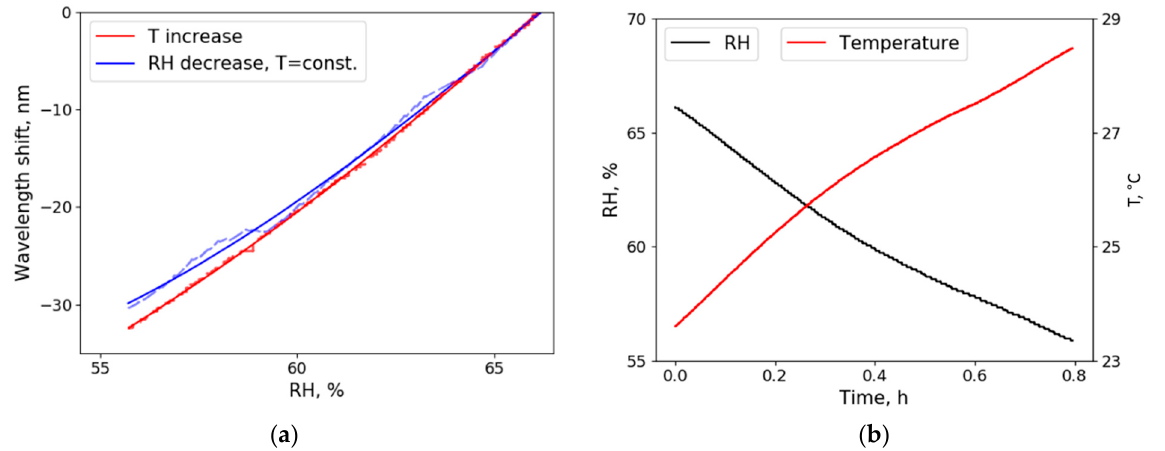
Figure 6. ( a ) Wavelength shift due to the RH change enforced only by dehumidifying the air (blue) and changing the temperature (red). Dotted lines illustrate raw data. To reduce RH, either silica gel desiccant or heating element (which increased the temperature from 23 to 28 °C) was used: The difference between the two curves represents the inaccuracy of the electric humidity sensor and the impact the temperature change has on the glycerol resonator. In an ideal case (no temperature dependence), both curves would match ideally; ( b ) Humidity and temperature change in the sealed chamber, when only temperature increased.